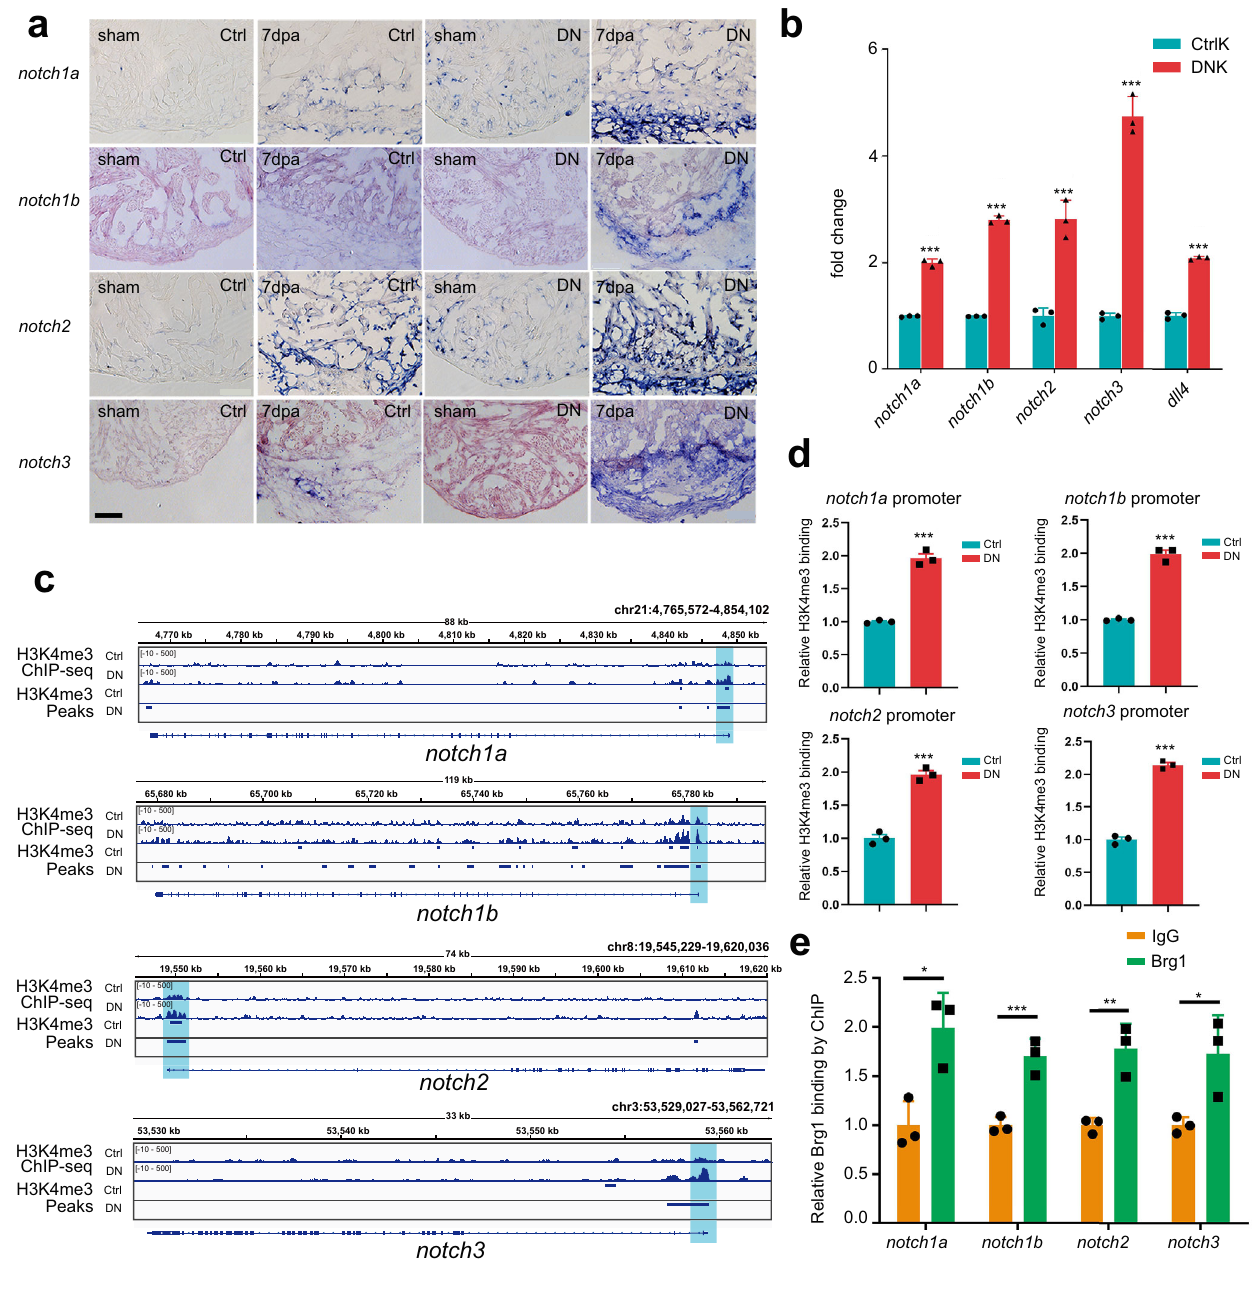
Fig. 3 Endothelium-speci fi c inhibition of Brg1 induces abnormal upregulation of Notch signaling via the increased levels of H3K4me3 in their promoters. a Representative images of RNA in situ hybridization with notch1a , notch1b , notch2 , and notch3 probes on frozen sections of sham-operated Ctrl hearts, injured Ctrl hearts, sham-operated DN hearts, and injured DN hearts at 7 dpa. Scale bar, 100 μ m. b Quantitative RT- PCR analysis showing that the expression of notch receptors and ligand in FACS-sorted kdrl:EGFP endothelial cells from the DNK group was higher than those from the CtrlK group. Data represented one of three independent experiments. Data were mean fold changes ± s.e.m., *** p < 0.005, unpaired t -test. c H3K4me3 ChIP-seq showing the traces and peak intervals of representative genomic loci from Ctrl and DN hearts. H3K4me3 peaks in both Ctrl and DN groups were shown as bars. Putative promoter regions were indicated in blue color. d Anti- H3K4me3 ChIP and quantitative PCR in Ctrl and DN hearts at 7 dpa (primers designed from notch receptor genomic regions: notch1a , − 171/ + 3 bp; notch1b , − 41/ + 58 bp; notch2 , − 263/ − 115 bp; notch3 , + 394/ + 504 bp; ATG site designed as + 1 bp). Data represented one of three independent experiments. Data were the mean fold changes ± s.e.m.; *** p < 0.005, unpaired t -test. e Anti-Brg1 ChIP and quantitative PCR in wild-type hearts at 3 dpa. Data represented one of two independent experiments. Data were the mean fold change ± s.e.m.; * p < 0.05, ** p < 0.01, *** p < 0.005; unpaired t -test. n number shown here ( b , d , e ) indicated technical